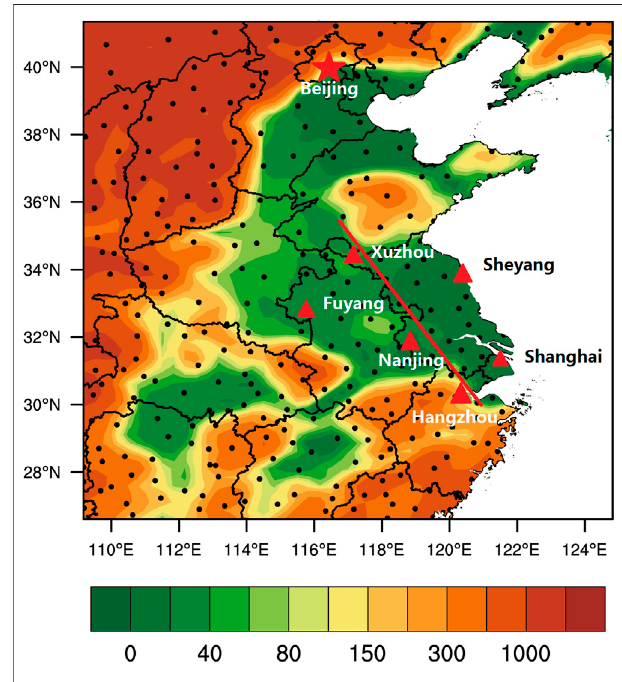
FIGURE 1 | The geographical environment of the Jianghuai area (where the red triangles region), referring to as Jiangsu and Anhui provinces in this article. The red triangles represent the primary meteorological stations (Xuzhou (XZ), Sheyang (SY), Fuyang (FY), Nanjing (NJ), Shanghai (SH), Hangzhou (HZ)) in the Jianghuai area, the red line is used to analyze the wind fi eld and the conceptual model, and the black dots are the other stations of CMA. The color is the